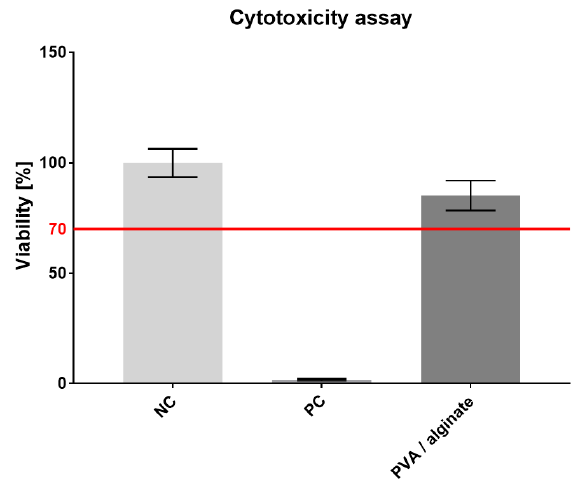
Figure 7. PVA/alginate fibrous layer cytotoxicity assay, 95% CI.